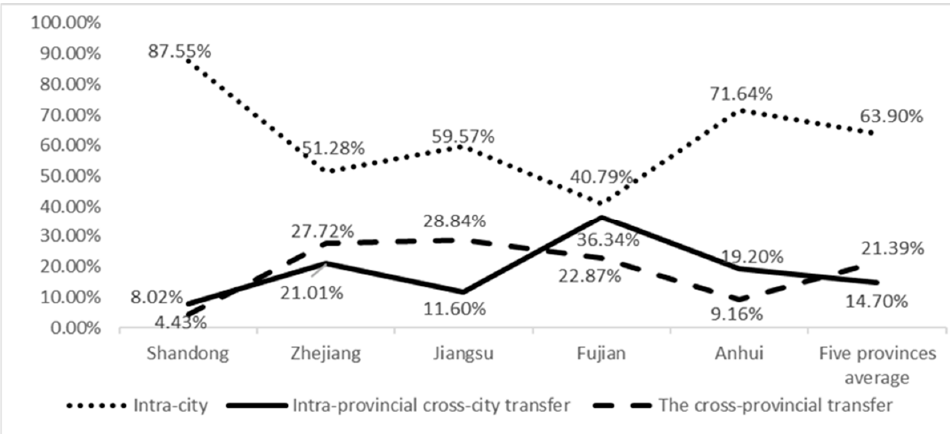
Figure 1. Average proportion of the cross-regional transfer of unquali fi ed products in the sample provinces.